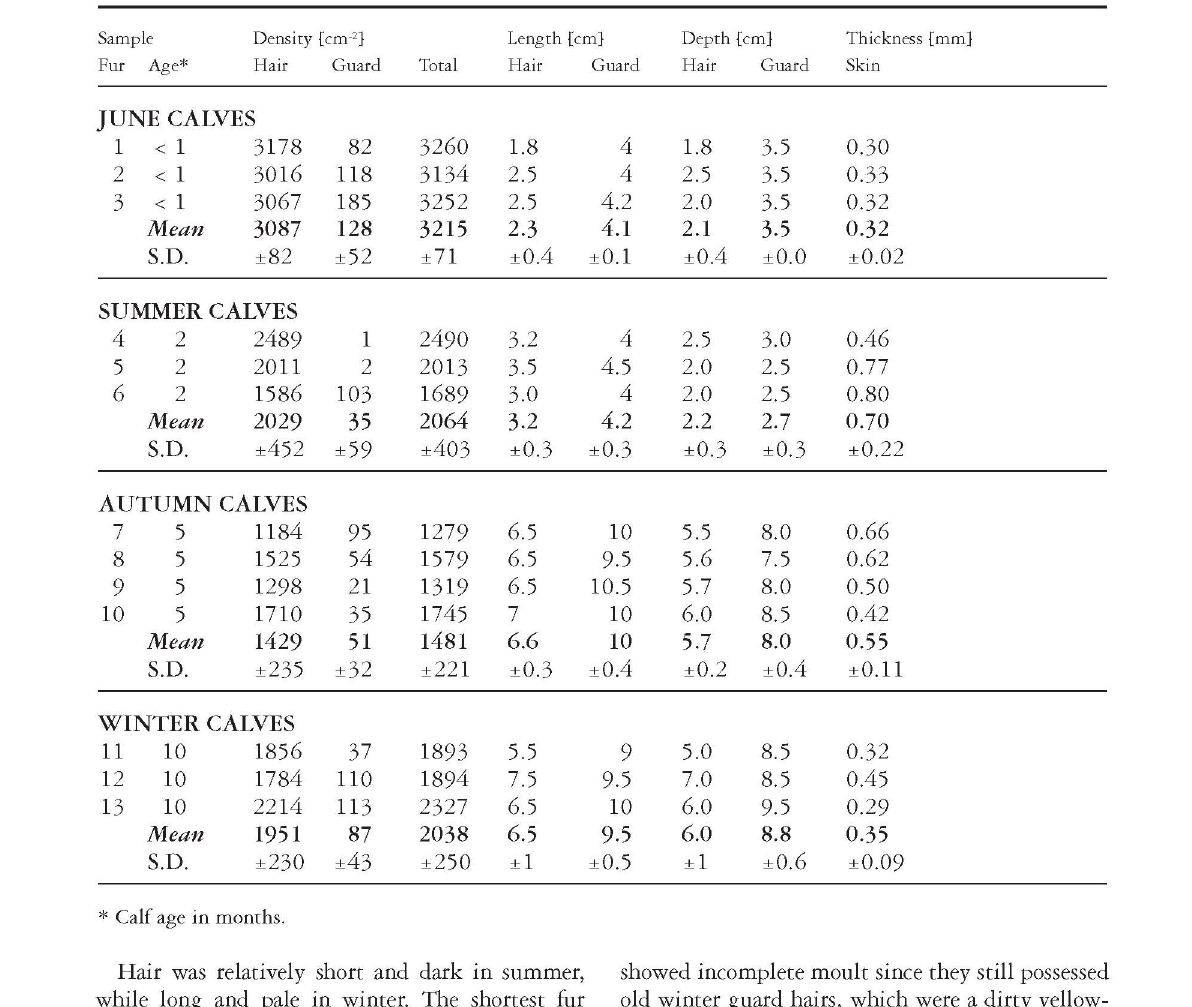
Table 2. Physical properties of Svalbard reindeer calves mid-back